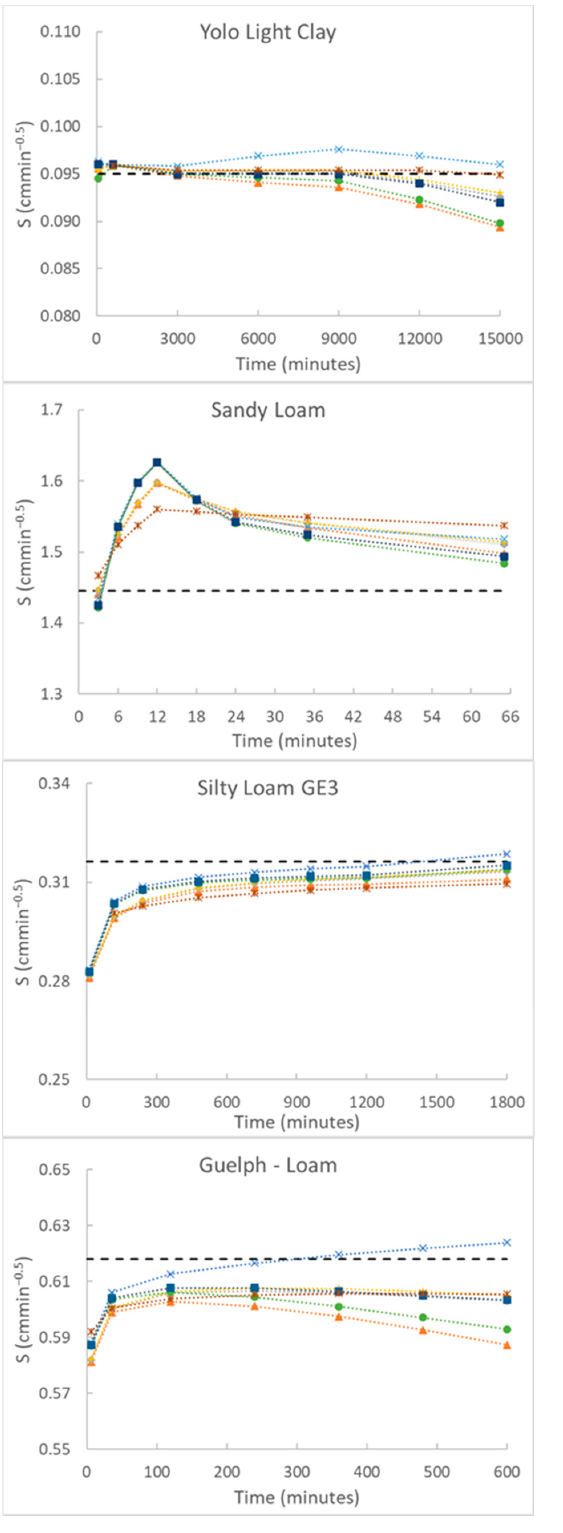
Figure 3. Comparative presentation of the actual values of S and K s and the predicted ones from Equations (1)–(7) by means of Excel Solver and Equation (8), with respect to the time, for all the soils studied.